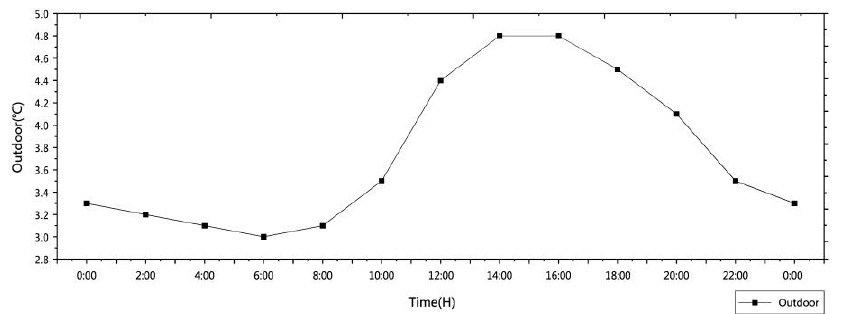
Figure 7. Outdoor temperature distribution.